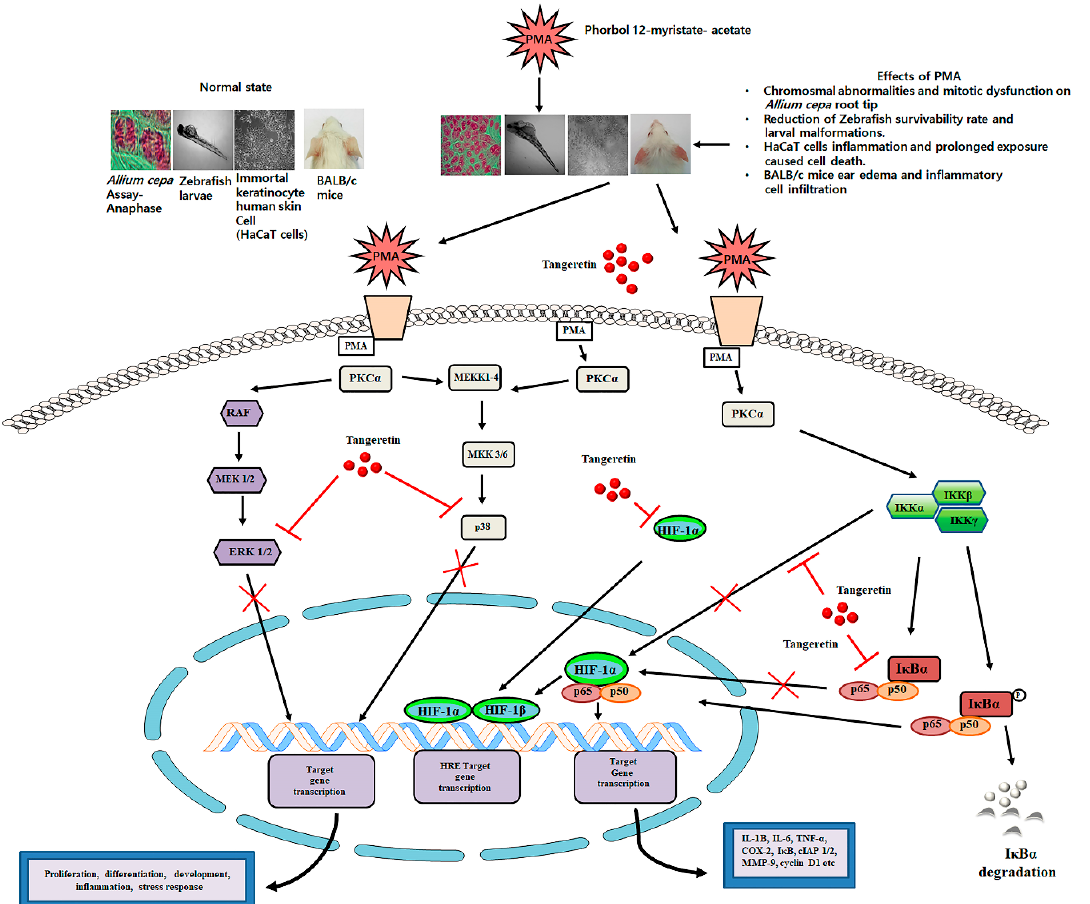
Figure 10. A schematic illustration of the role of tangeretin in counteracting PMA-induced inflammatory response on in vitro and in vivo model systems.